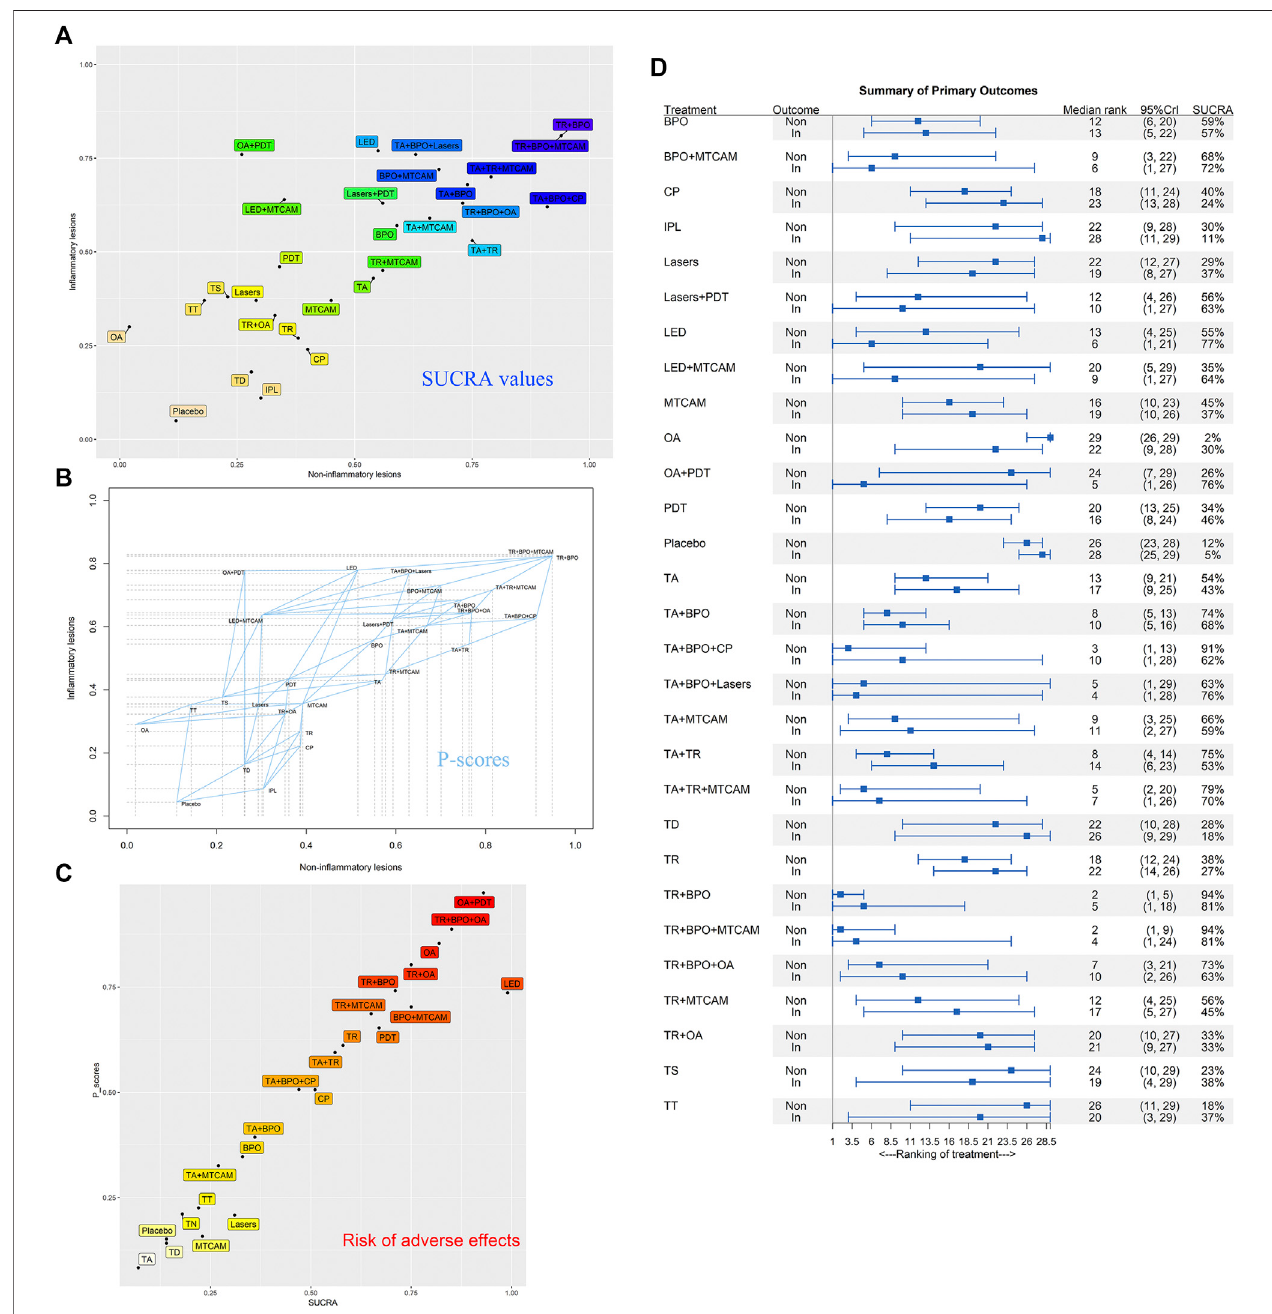
FIGURE7| BiplotsofSUCRAvaluesandP-scoresforef fi cacyandsafetyoutcomes. (A) SUCRAvaluesofnonin fl ammatoryandin fl ammatorylesionscount. (B) P-scoresof nonin fl ammatory and in fl ammatory lesions count. (C) SUCRA values and P-scores of adverse effects. (D) Median rank and 95%CrI of summarized primary outcomes.